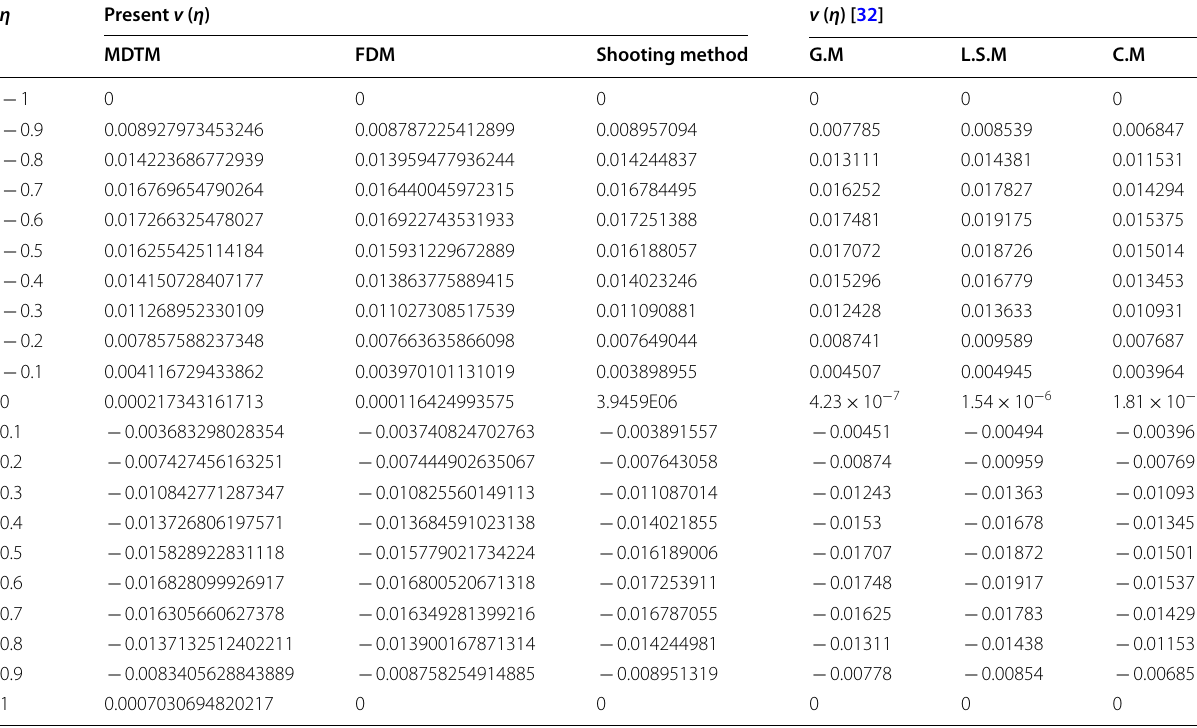
Table 2 Comparison solution by MDTM, FDM, and shooting method with GM, LSM, and CM [32] for V ( η ) when ϕ Ha 3, R 2, Ec 1, Pr 6.2, and α d = = = = =